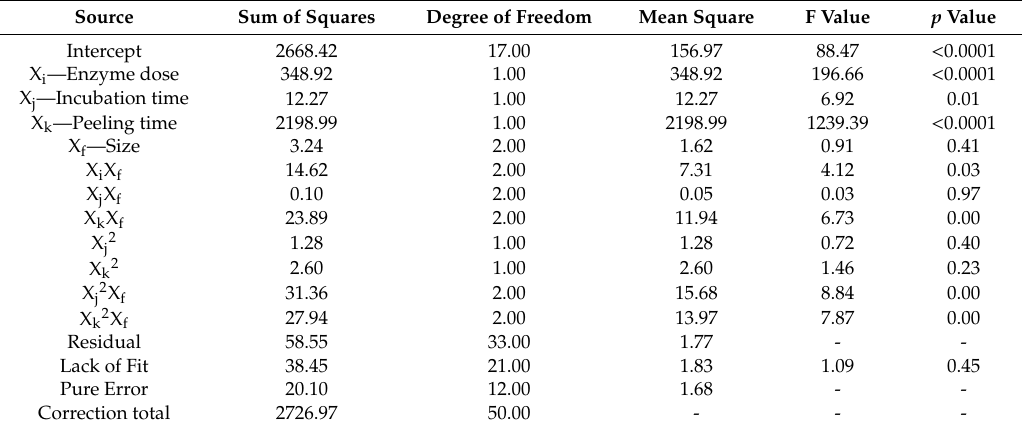
Table 6. ANOVA for reduced polynomial equation for the effect of enzymatic treatment, peeling time and size of tubers on the peel loss of cassava tubers. Source Sum of Squares Degree of Freedom Mean Square F Value p Value Intercept 2668.42